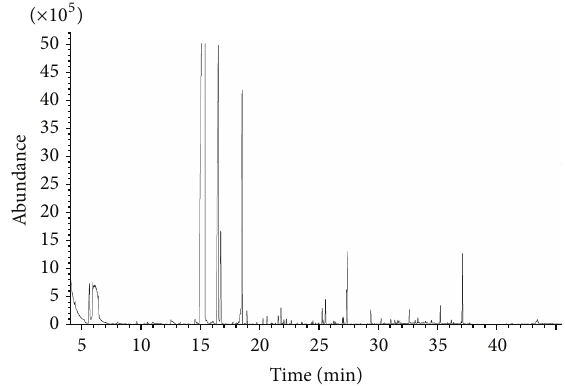
Figure 2: Chromatograms of the volatile compounds in foxtail millet